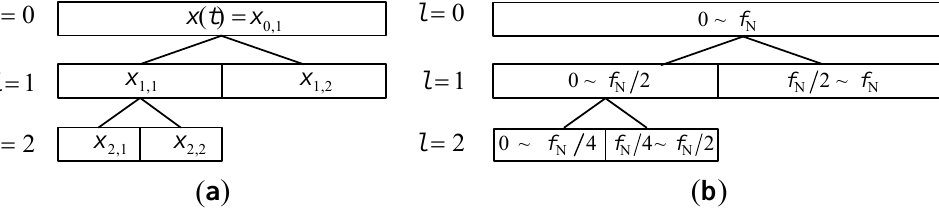
Figure 2. ( a ) The decomposition step of multiwavelet transform and ( b ) the corresponding frequency bands.